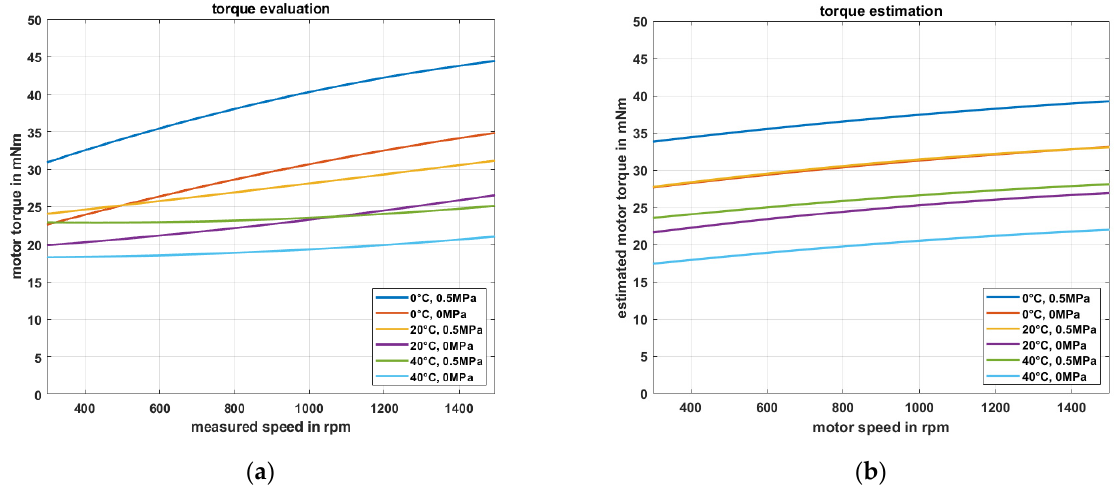
Figure 30. Torque validation: ( a ) Illustration of the approached torque curve depending on speed at all measured conditions regarding temperature and load pressure; ( b ) results of torque estimation as stated at Equation (13) for material and geometry data of prototype.